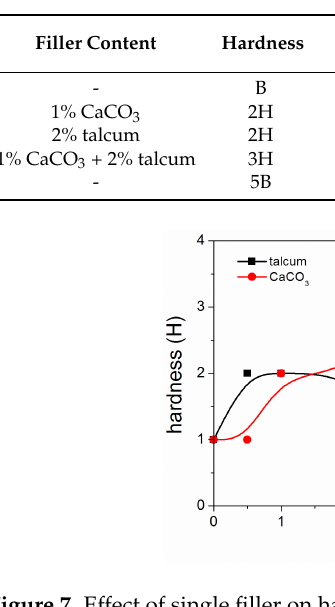
Figure 7. Effect of single filler on hardness of coating (sample 5, 11–24 in Table 1).